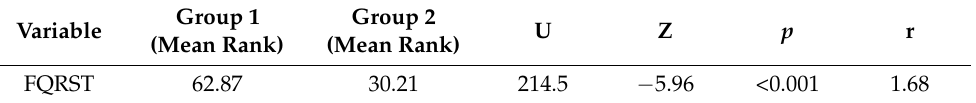
Table 3. Comparison of recorded parameters (Mann Whitney test) between group 2 ( n = 51, with moderate PAL) and group 3 ( n = 38, with high PAL), grouping variable IPAQ category.